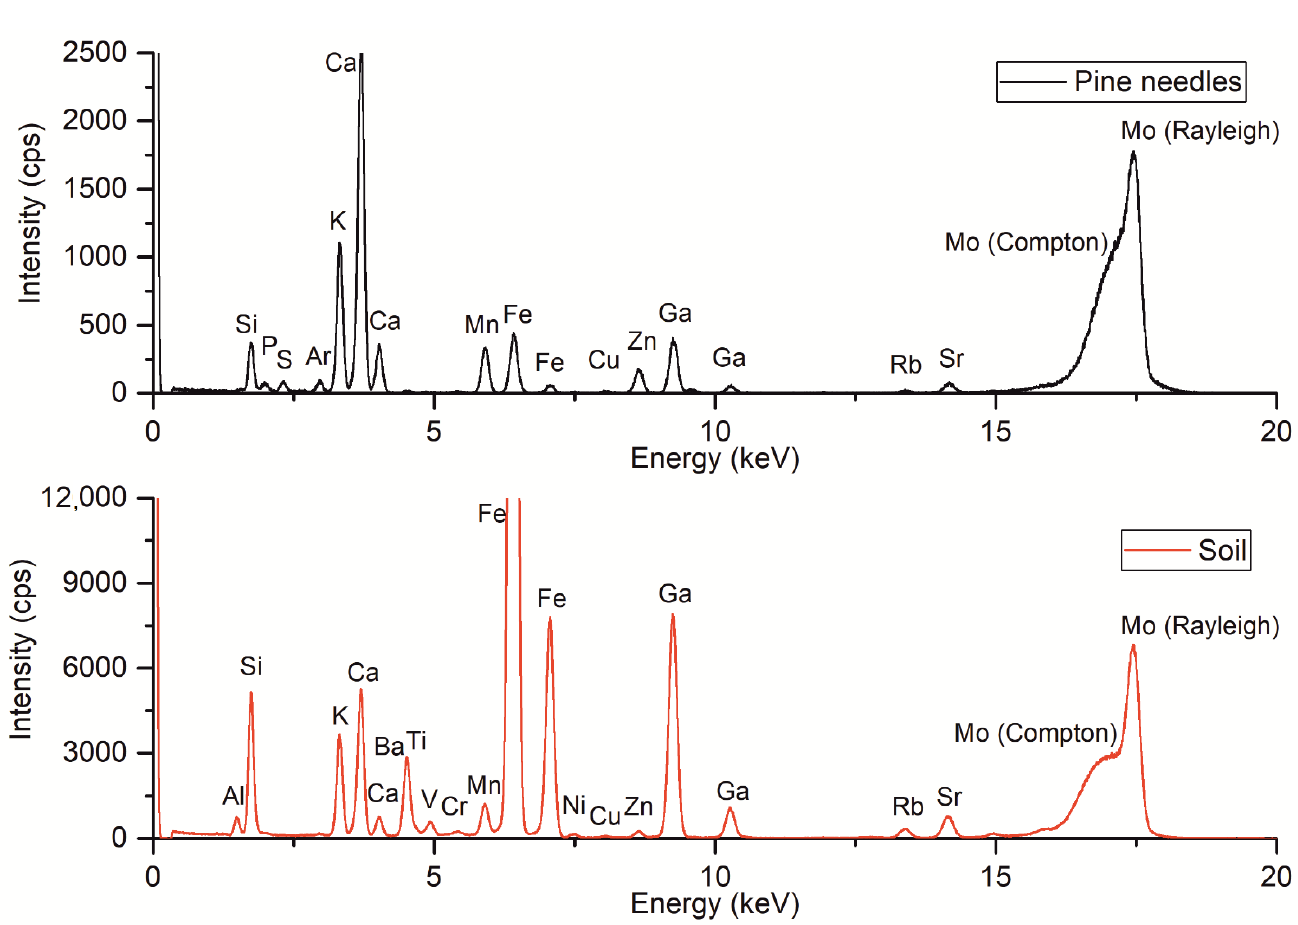
Figure 3. TXRF typical spectra of pine needle (black line) and soil (red line) samples. Table 3. Statistical data obtained for WDXRF analysis of major and trace elements in pine needle